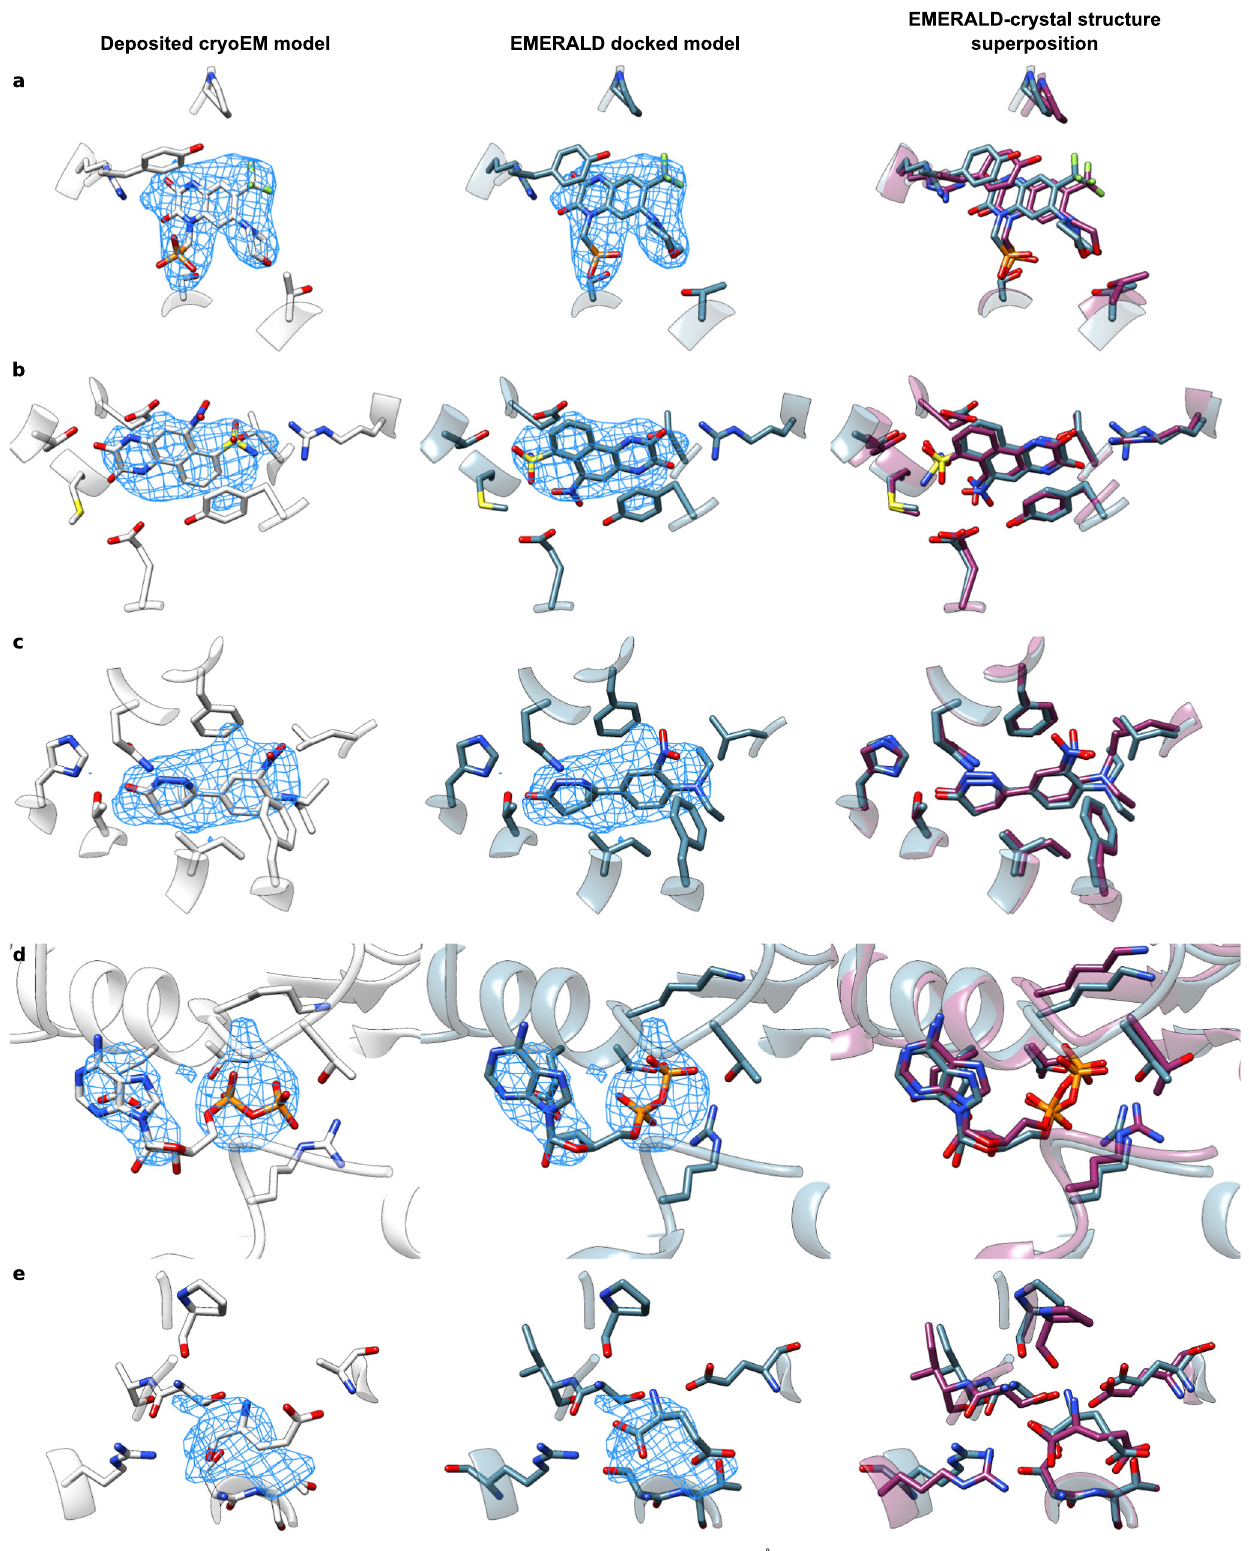
Fig. 3 | Alternate conformations predicted with EMERALD match high- resolution crystal structures. a – e Comparison of the deposited model (left, white), EMERALD model (center and right, blue), and higher resolution crystal model (right, purple). a Antagonist ZK200775 in AMPA receptor (EMDB: 23292, PDB: 7LEP, local resolution: 3.45Å) and its associated crystal model (PDB: 5ZG2). b Molecule NBQX bound to the AMPA receptor (EMDB: 12805, PDB: 7OCE, local